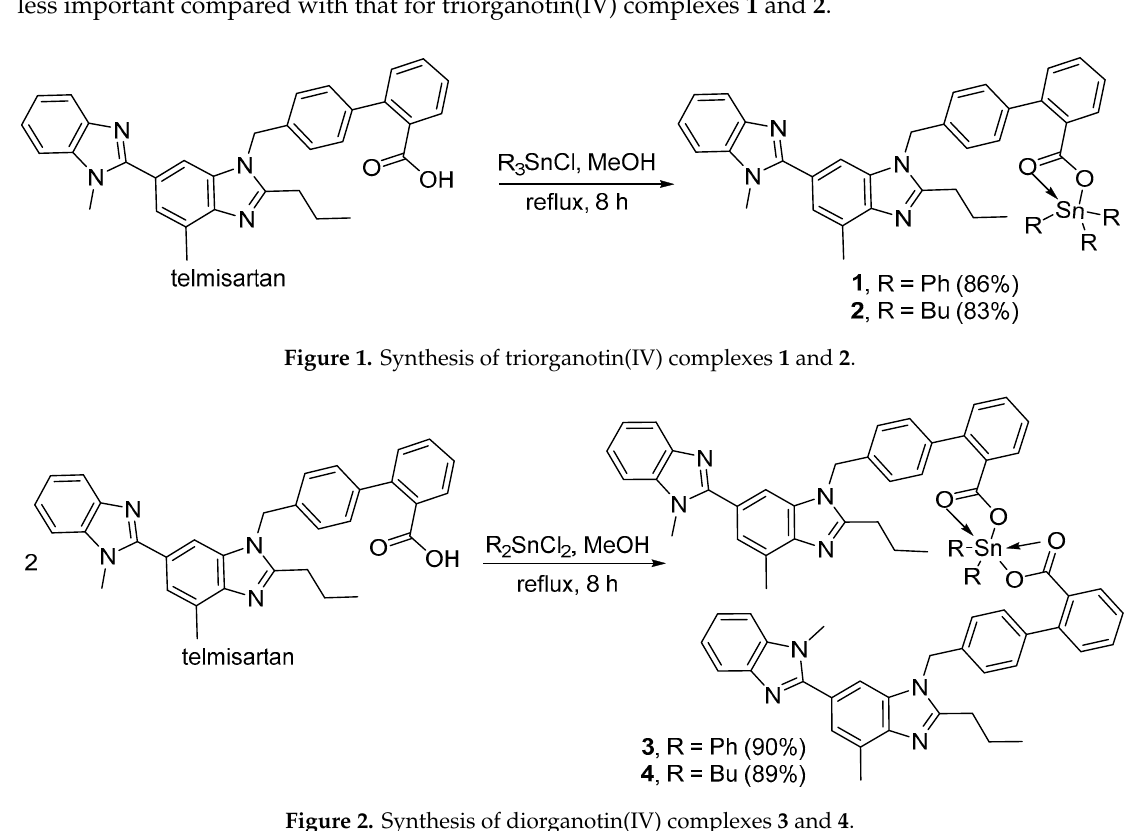
Figure 2. Synthesis of diorganotin(IV) complexes 3 and 4 . Table 1. Physical properties and elemental analysis of 1 – 4 .